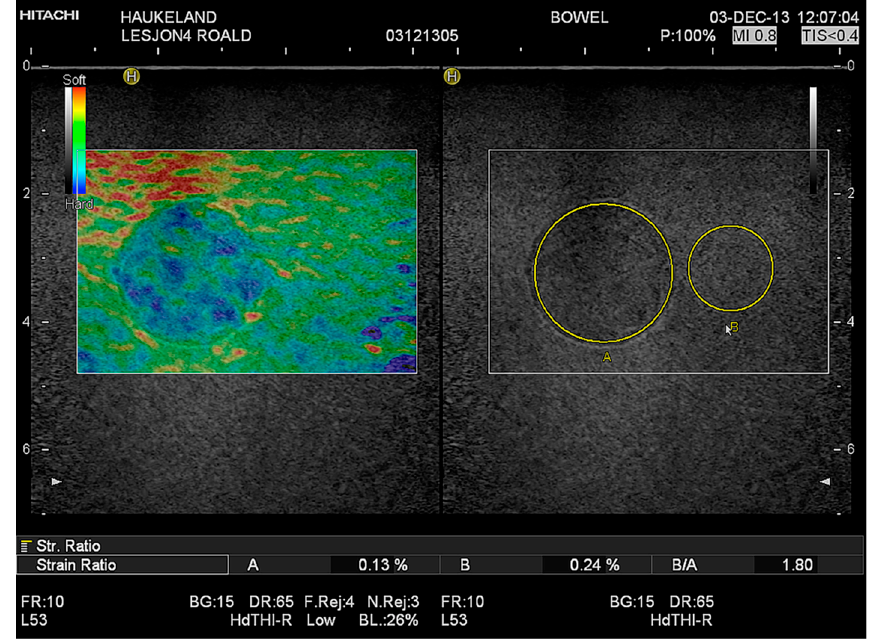
Figure 2. Elastogram from a tissue-mimicking phantom displaying a spherical inclusion (80 kPa) with a diameter of two cm in a background of 25 kPa. Right side: B-mode image with area markings. A (lesion) and B (reference). Left side: elastogram in color coding. The stress source was working from above in the axial direction. The lesion is speckled and green-blue, whereas the background material is mostly homogeneously green. Between the lesion and the probe, the red color indicates strain concentration between the stress source and the harder lesion. The strain ratio ( SR ) is mean strain in B/mean strain in A = 1.80.